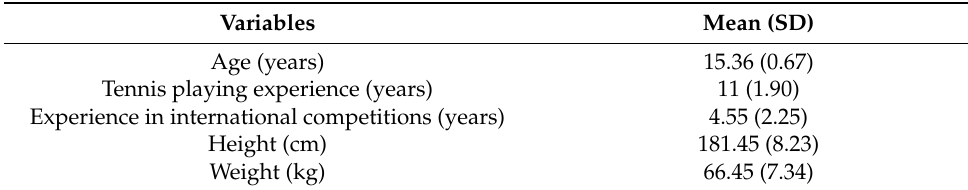
Table 1. Descriptive data of participants.